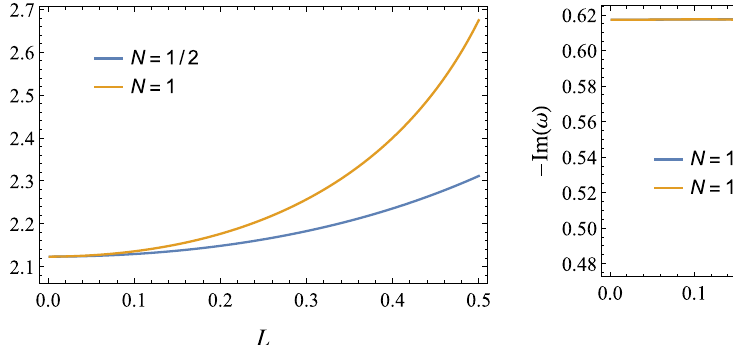
tively; the right diagram represents the negative imaginary parts of ω with respect to L for the cases of N = 1 / 2 and N = 1, respectively